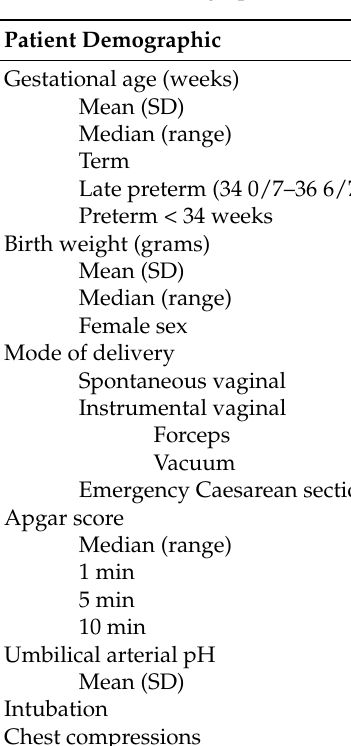
Table 1. Patient demographics of 48 newborns receiving